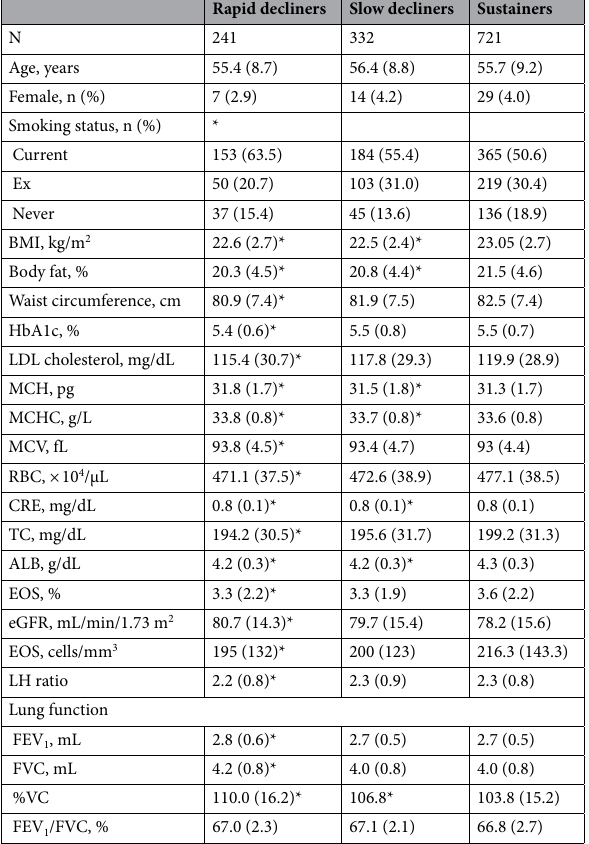
Table 1. Patient characteristics. *Statistically significant difference vs sustainers at < 0.05 found by the Fisher exact test. Data are presented as mean (SD) unless stated otherwise. ALB albumin, BMI body mass index, CRE creatinine, eGFR estimated glomerular filtration rate, EOS eosinophil, FEV 1 forced expiratory volume in 1 s, FVC forced vital capacity, HbA1c hemoglobin A1c, LDL low-density lipoprotein, LH ratio LDL/HDL ratio, MCH mean corpuscular hemoglobin, MCHC mean corpuscular hemoglobin concentration, MCV mean corpuscular volume, N number of subjects, RBC red blood cell, SD standard deviation, TC total cholesterol, VC vital